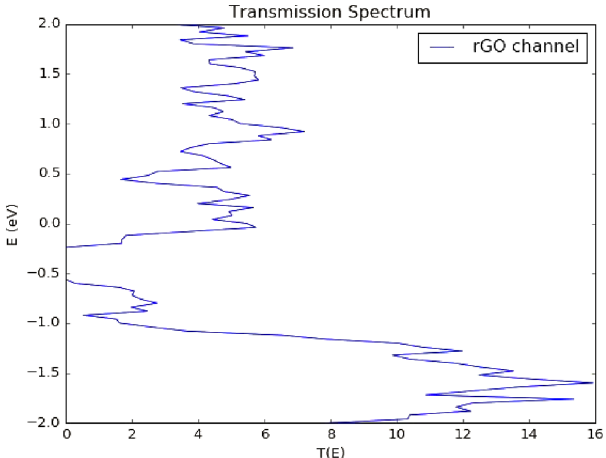
Figure 8. rGO channel’s transmission spectrum. Produced by QuantumATK software (version